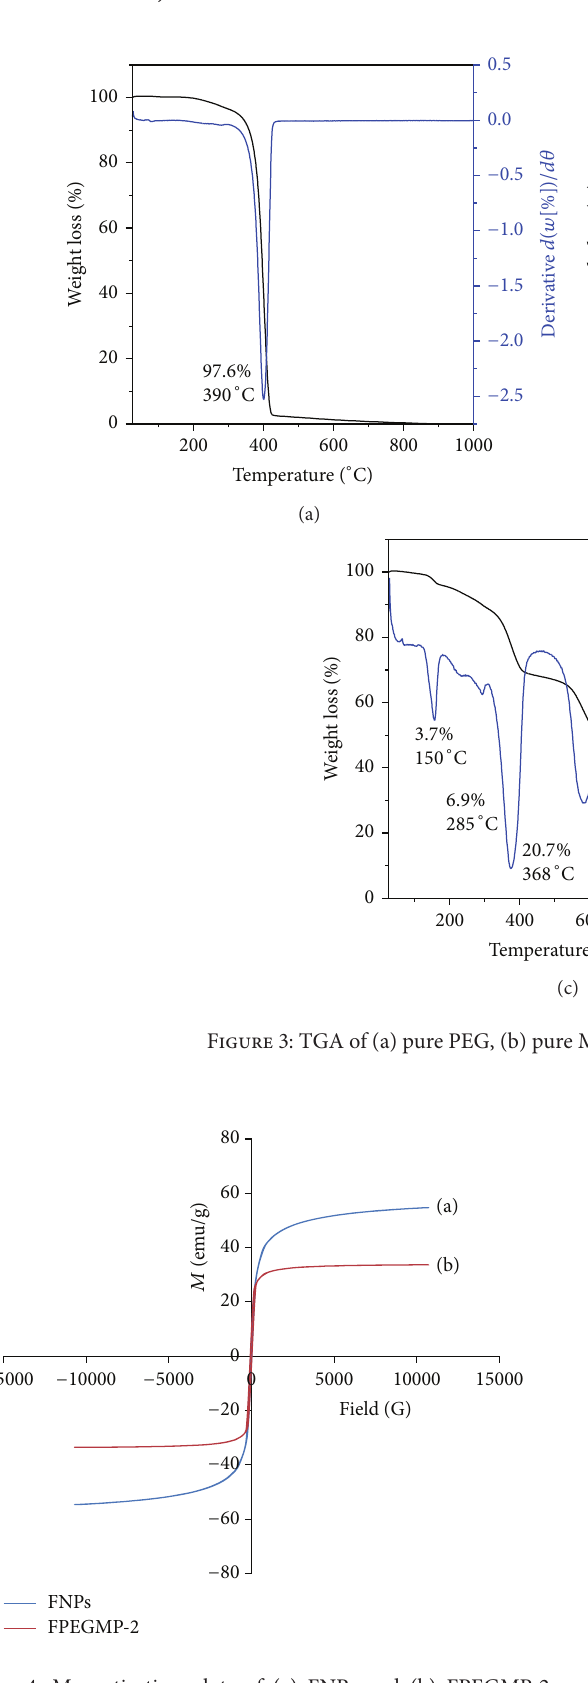
Figure 4: Magnetization plots of (a) FNPs and (b) FPEGMP-2 nanocomposite.